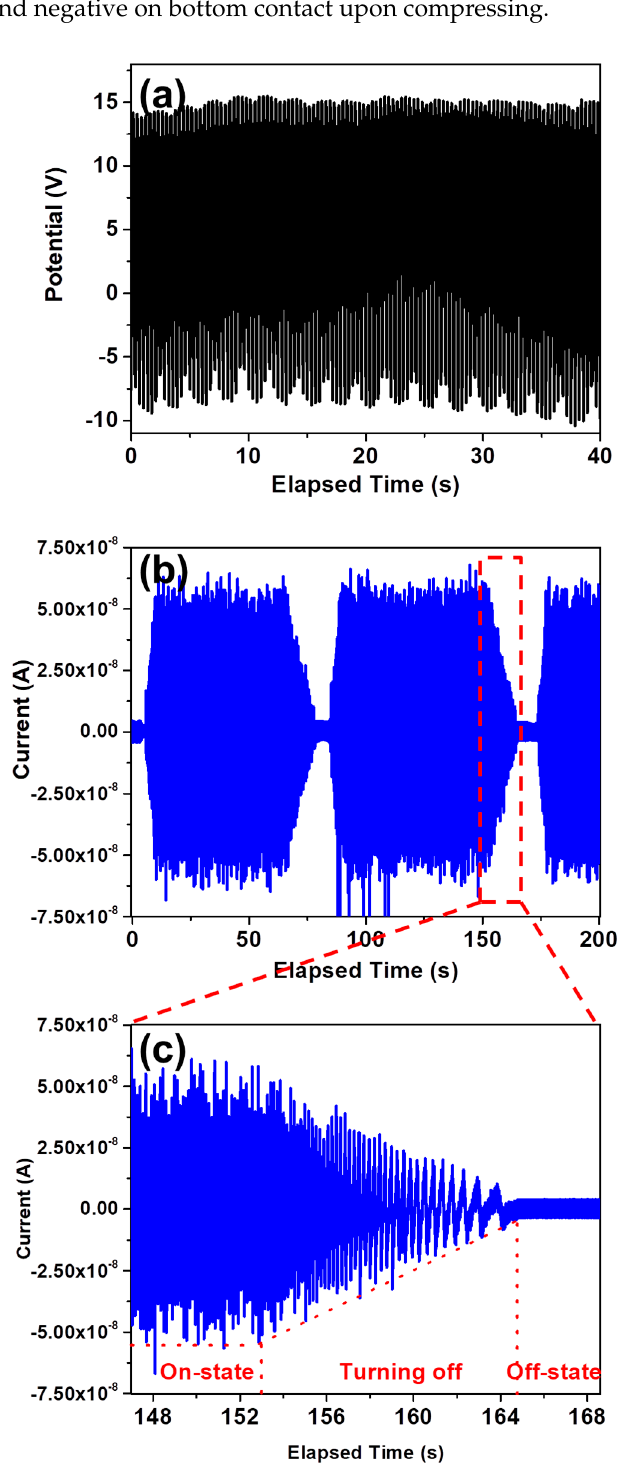
Figure 3. Piezoelectric outputs of PNG ( a ) open circuit voltages; ( b ) short circuit current; and, ( c ) magnified view of output current with decreasing frequency.